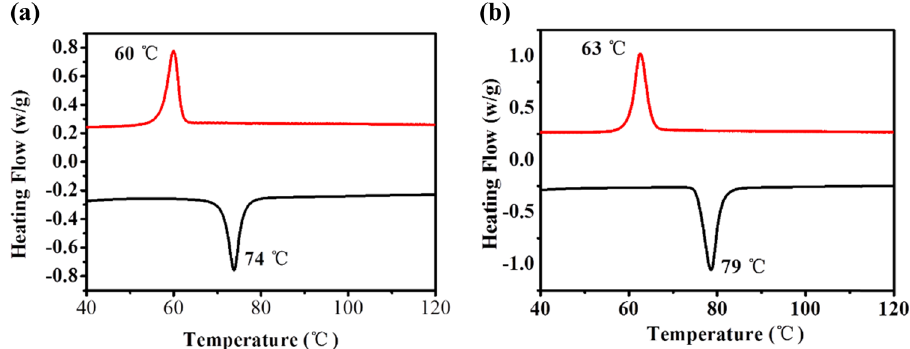
Figure 4: DSC traces for PDMA 21 - b - PHDFA 40 fl uorinated block copolymer nanoobjects ( a ) and PHDFA 40 ( b ) homopolymer. The red and black lines refer to the cooling half - cycle and heating half - cycle,